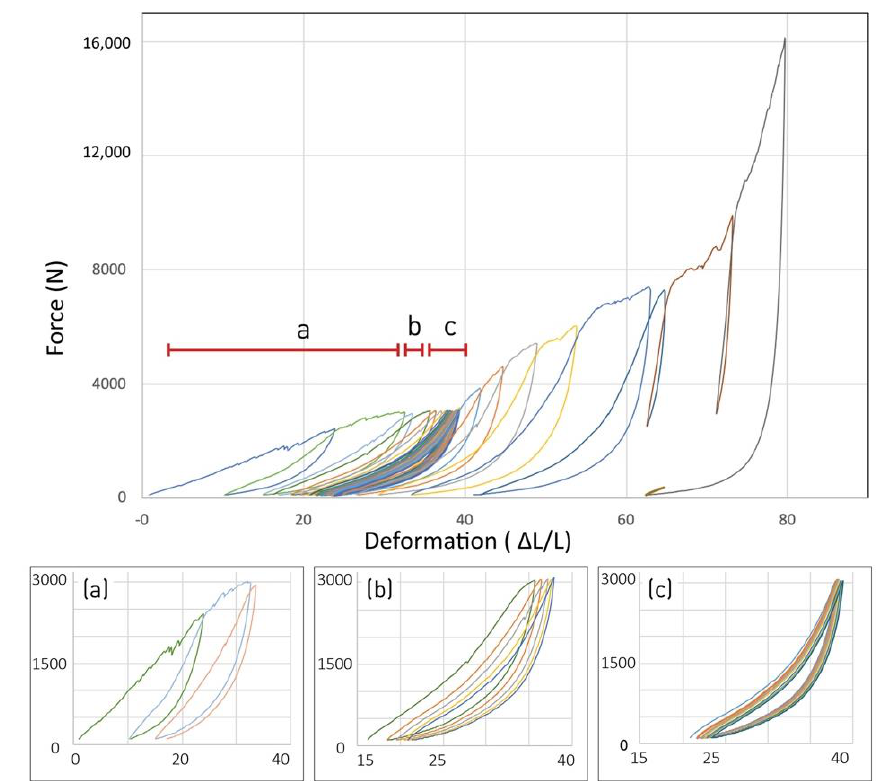
Figure 6. Typical loading/unloading curve: evolution along test sets. Sections in detail below: ( a ) settling, ( b ) first hysteretic cycles, ( c ) steady repeated cycles ( Experimental campaign1_sample01 ).